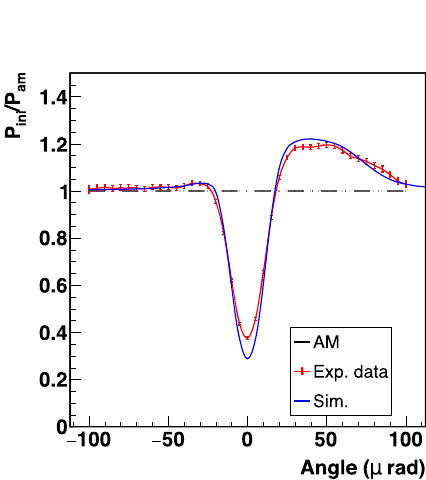
Table 1 Crystal parameters: name, physical dimensions ( L X , L Y , L Z ), bending angle ( α ), planar channeling efficiency